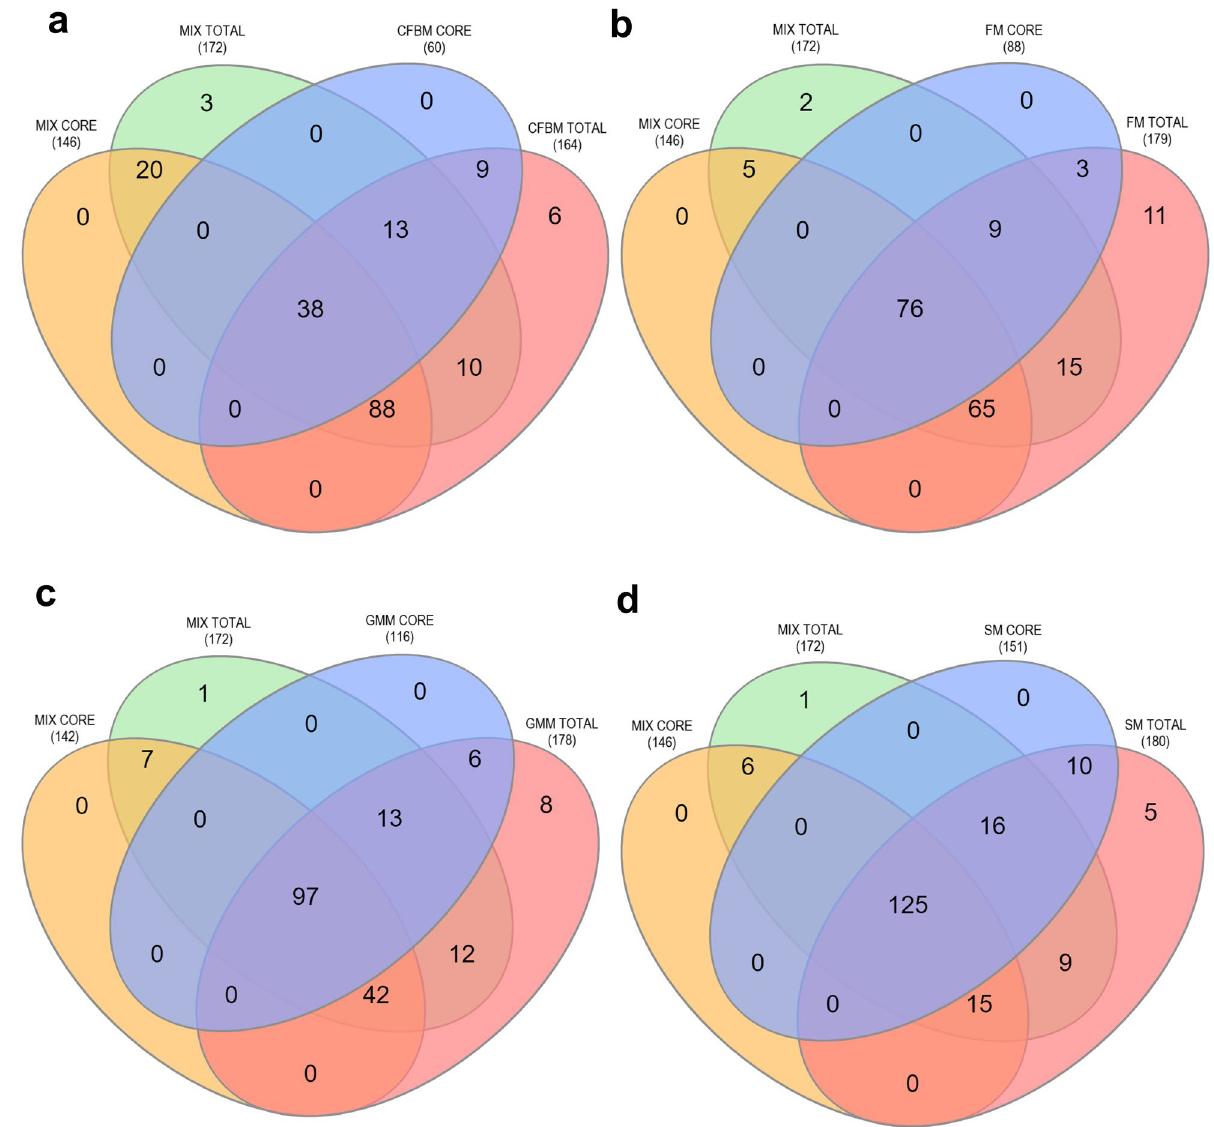
Figure 5. Core microbiota analysis. Venn diagram depicting unique and shared ASVs between CFBM ( a ), FM ( b ), GMM ( c ), and SM ( d ) after 24 h cultivation and non-cultured MIX inoculum is presented as a number of observed ASVs. Samples represent viable bacteria after PMA